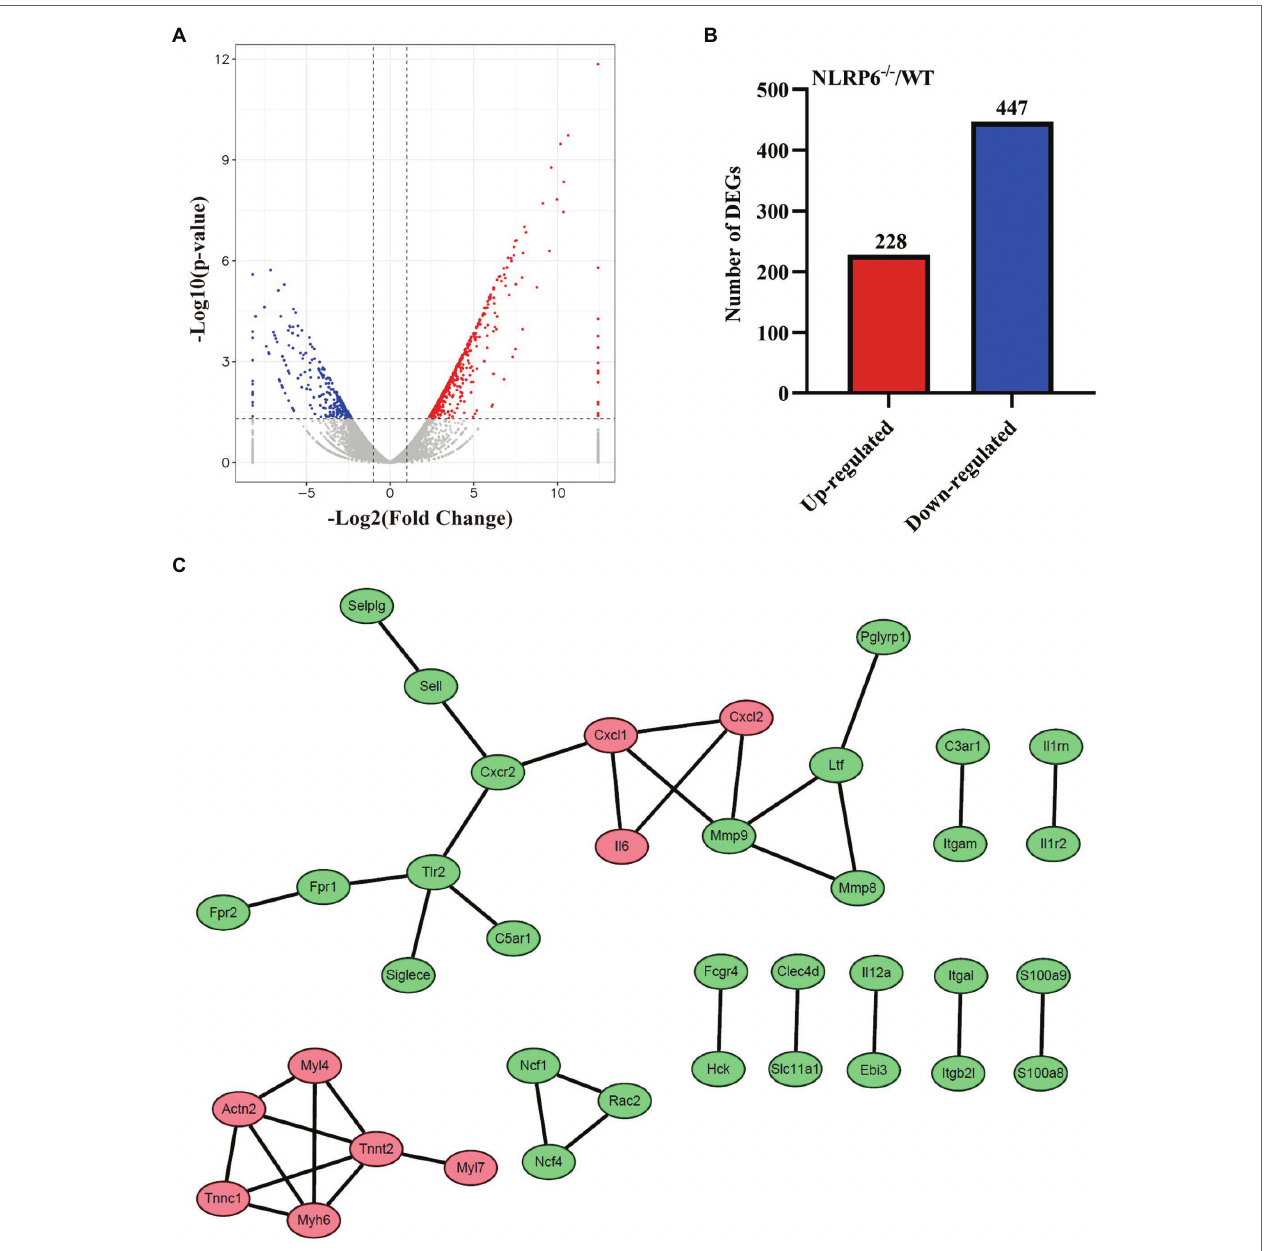
FIGURE 2 | DEGs identification of lung tissue from S. pneumoniae -infected WT and NLRP6 − / − mice. WT and NLRP6 − / − mice were intranasally infected with S. pneumoniae (5 × 10 7 CFU) for 24 h and then lung tissues were collected for transcriptome analysis. (A) Volcano plot of differentially expressed genes (DEGs). The two vertical dotted lines are the twofold expression difference threshold, the horizontal dotted line represent value of p = 0.05. (B) The up/down-regulated DEGs of WT and NLRP6 − / − . (C) Protein–protein interaction (PPI) network of the top 200 DEGs with the most significant difference in value of p (score > 0.95). The red circles represent the upregulated DEGs, the green circles represent the downregulated